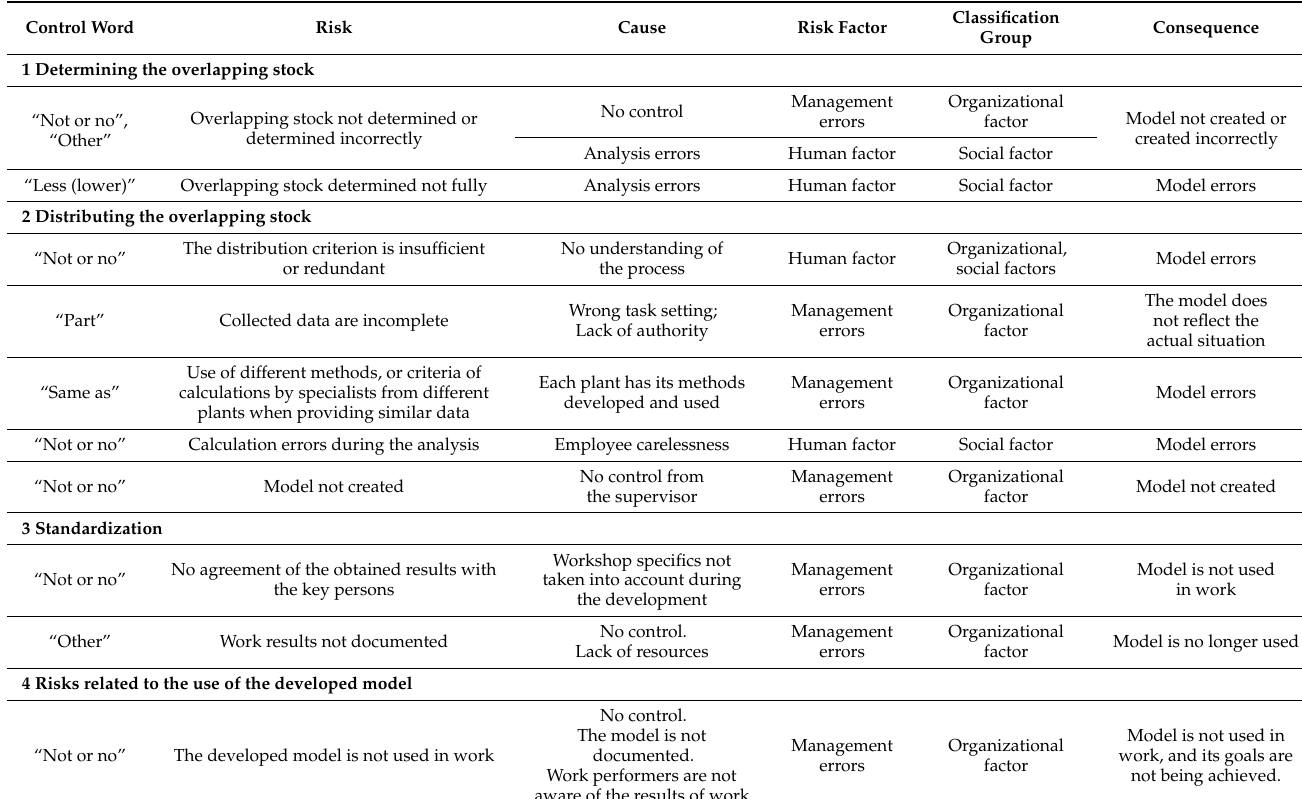
Table 1. Register of the risks for the process of “Developing a Model of Rolling Mill Loading with Orders with Overlapping